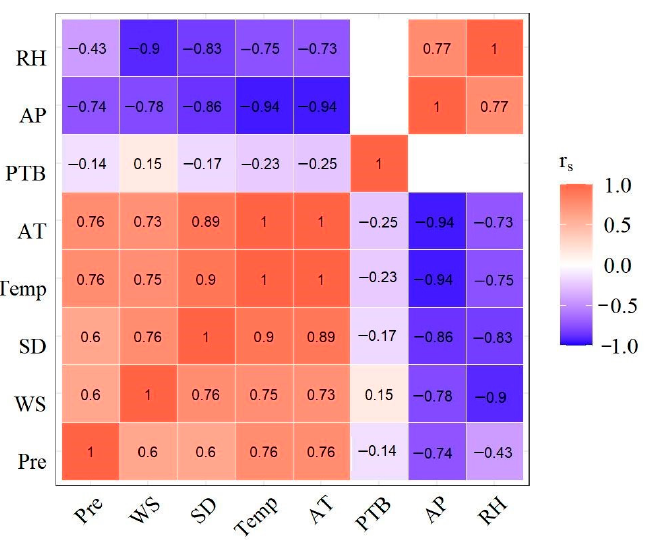
Figure 2. Spearman’s rank correlation results between the cases number of PTB and meteorological factors in Xinjiang from 2004 to 2019. Abbreviations: Temp, air temperature ( ◦ C); AT, apparent temperature ( ◦ C); SD, sunshine duration (h); RH, relative humidity (%); AP, air pressure (hPa); Pre, precipitation (mm); WS, wind speed (m/s); r s , Spearman’s rank correlation coefficient.